Question: What visual encoding does this figure use to show its data?
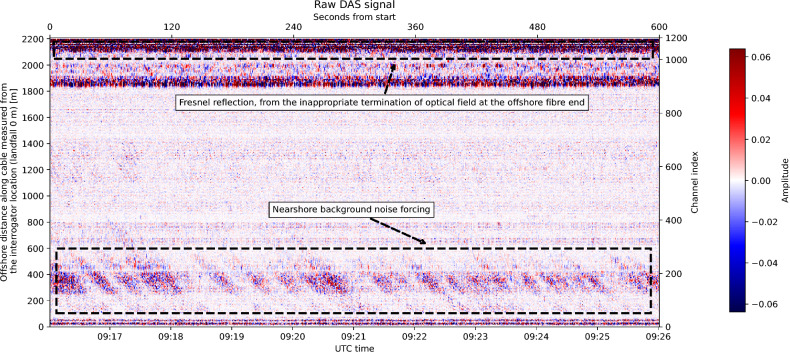
Answer: line